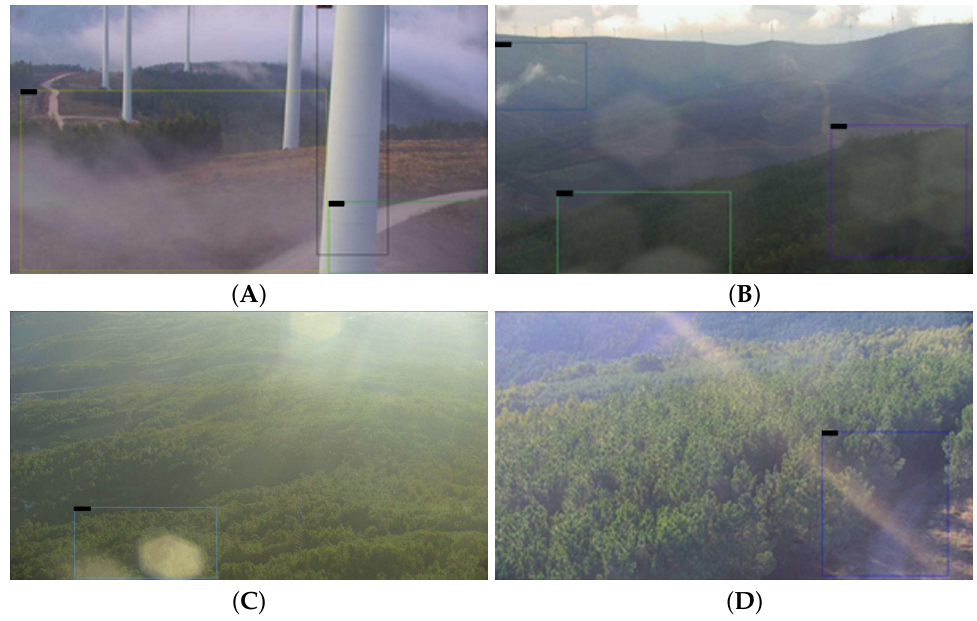
Figure 3. Examples of false positives detected with over 50% probabilities. In example ( A ), bounding boxes are shown with detections of a pole and fog in front of the camera. Example ( B ) shows three bounding boxes, with only one being truly positive, while the other two are water drops in the lens. In example ( C ), there is a heavy fog in front of the camera that causes a False Positive to be produced. Example ( D ) shows a reflection of the sun which, when superimposed on a road, resulted in a False Positive.